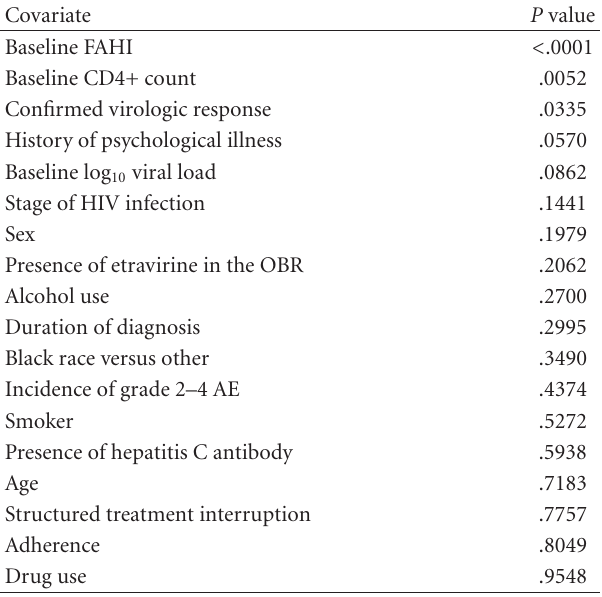
Table 2: Results from the univariate analysis to investigate factors associated with improvements in total FAHI score over 48 weeks.